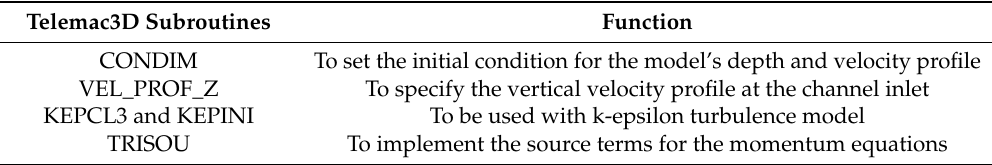
Table 1. List of Telemac3D subroutines used in this study and their corresponding